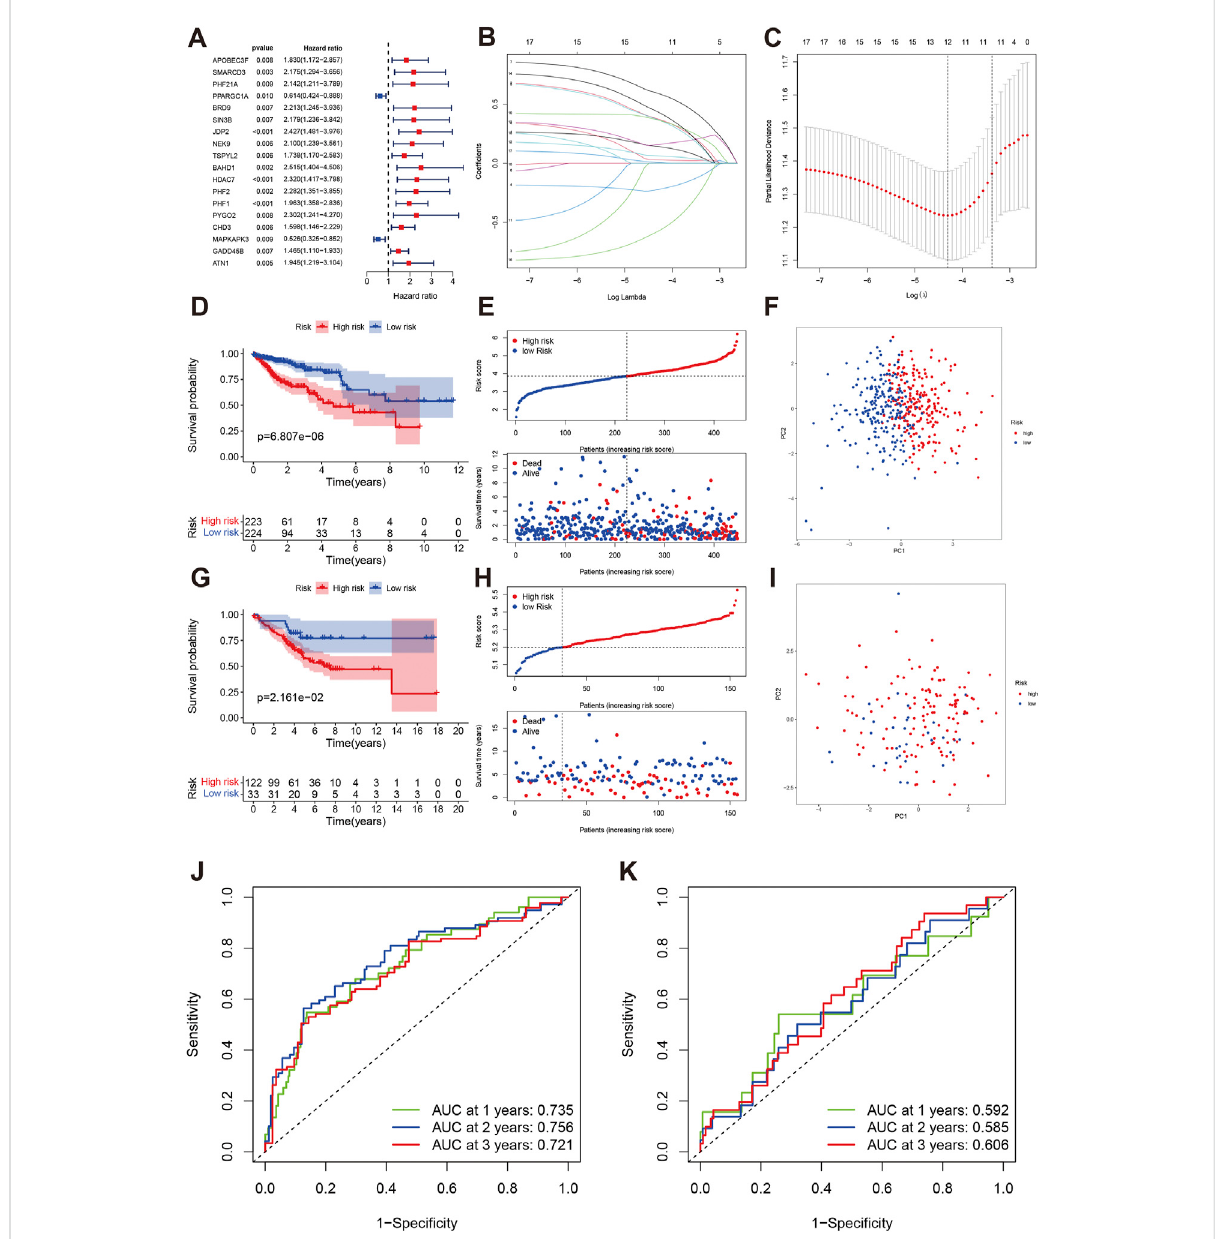
FIGURE 5 Development and validation of a chromatin regulator prognostic model in COAD. (A) The forest plot of univariate cox regression. (B,C) LASSO regressionidenti fi edthenumberofgenesincludedinthemodel. (D – F) TheKaplan-Meiersurvivalcurve,riskscoreandsurvivaltimesdistributionand PCA in TCAG training cohort. (G – I) The Kaplan-Meier survival curve, risk score and survival times distribution and PCA in GEO validation cohort. (J) ROC of risk score at 1-year, 2-year, 3-year in TCGA. (K) ROC of risk score at 1-year, 2-year, 3-year in